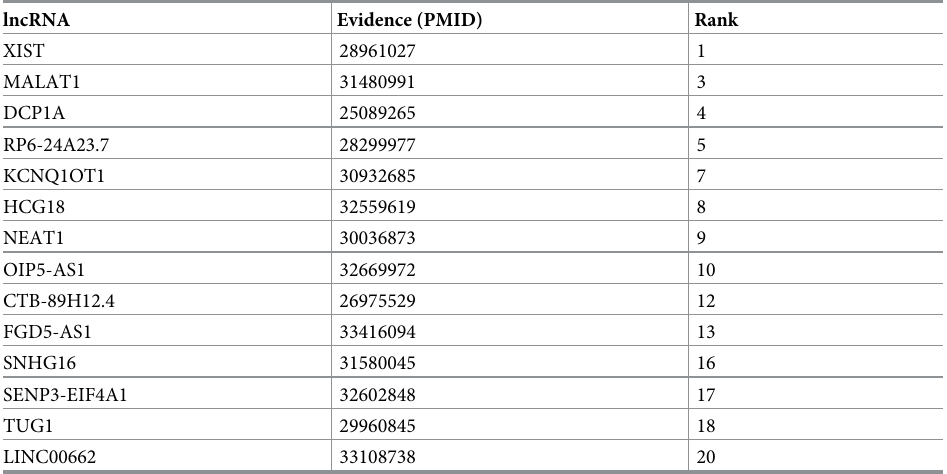
Table 3. Top 20 lncRNA of adenocarcinoma predicted by LDAP-WMPS.